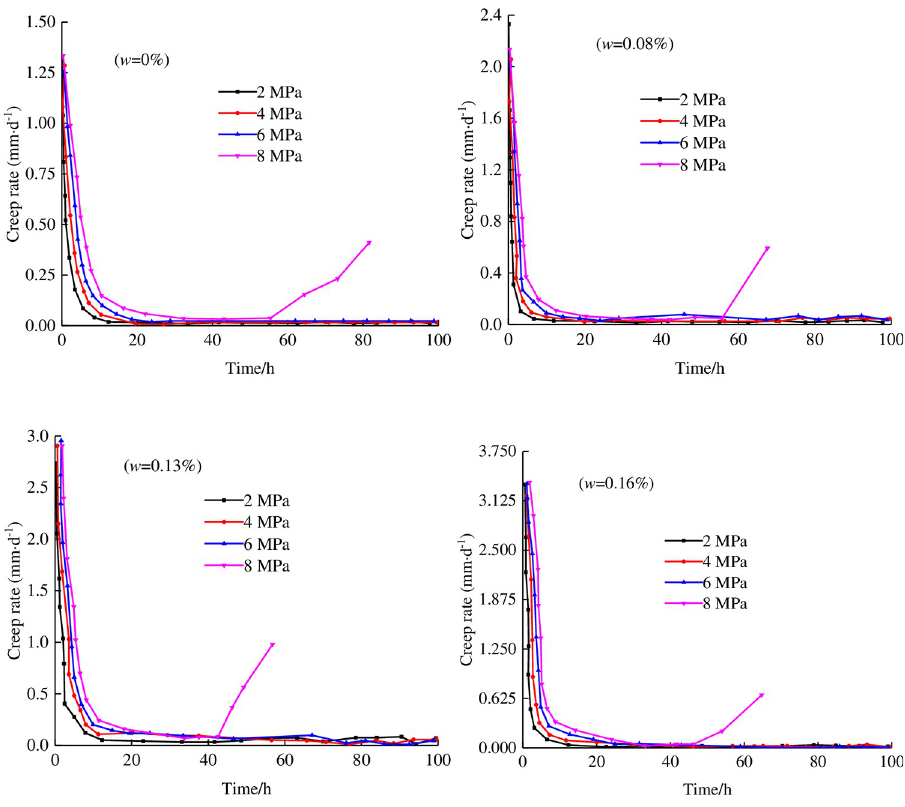
Fig 8. Shear creep rating-time curves of the anchorage rock mass under different water